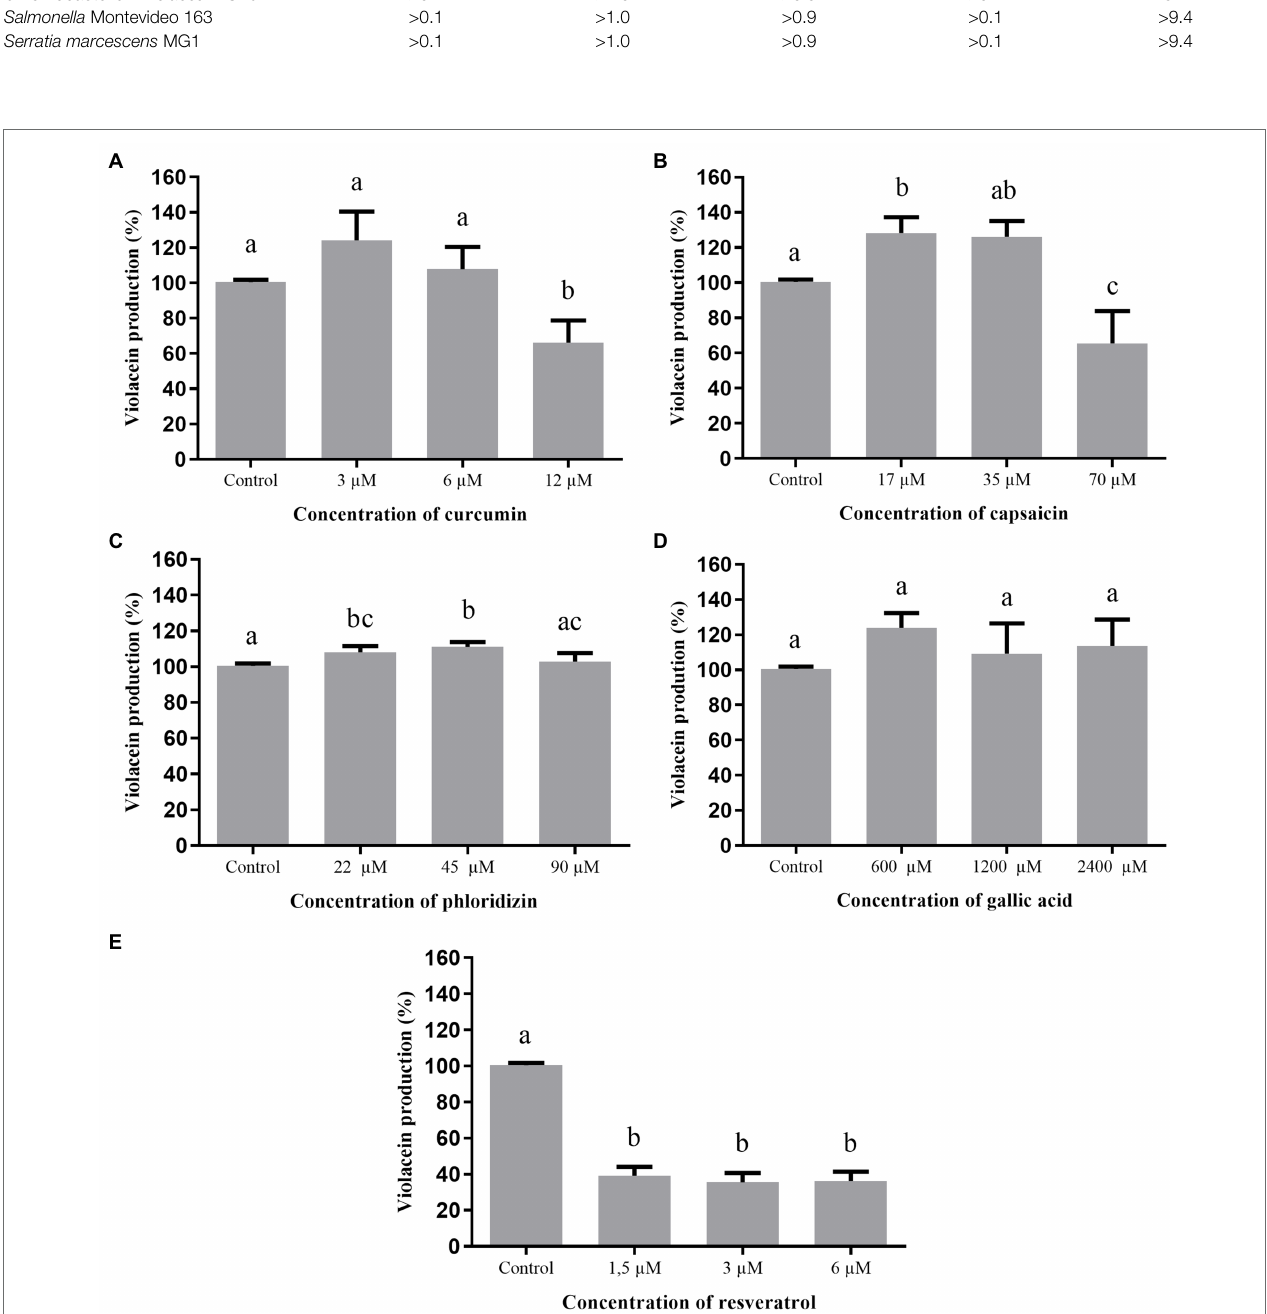
FIGURE 2 | Effect of phenolic compounds on violacein production by Chromobacterium violaceum ATCC 12472 expressed as percentage of production, when compared to the control (100%). Curcumin (A) ; capsaicin (B) ; phloridizin (C) ; gallic acid (D) ; resveratrol (E) ; and control = violacein production in LB broth + dimethyl sulfoxide (DMSO; 1%).